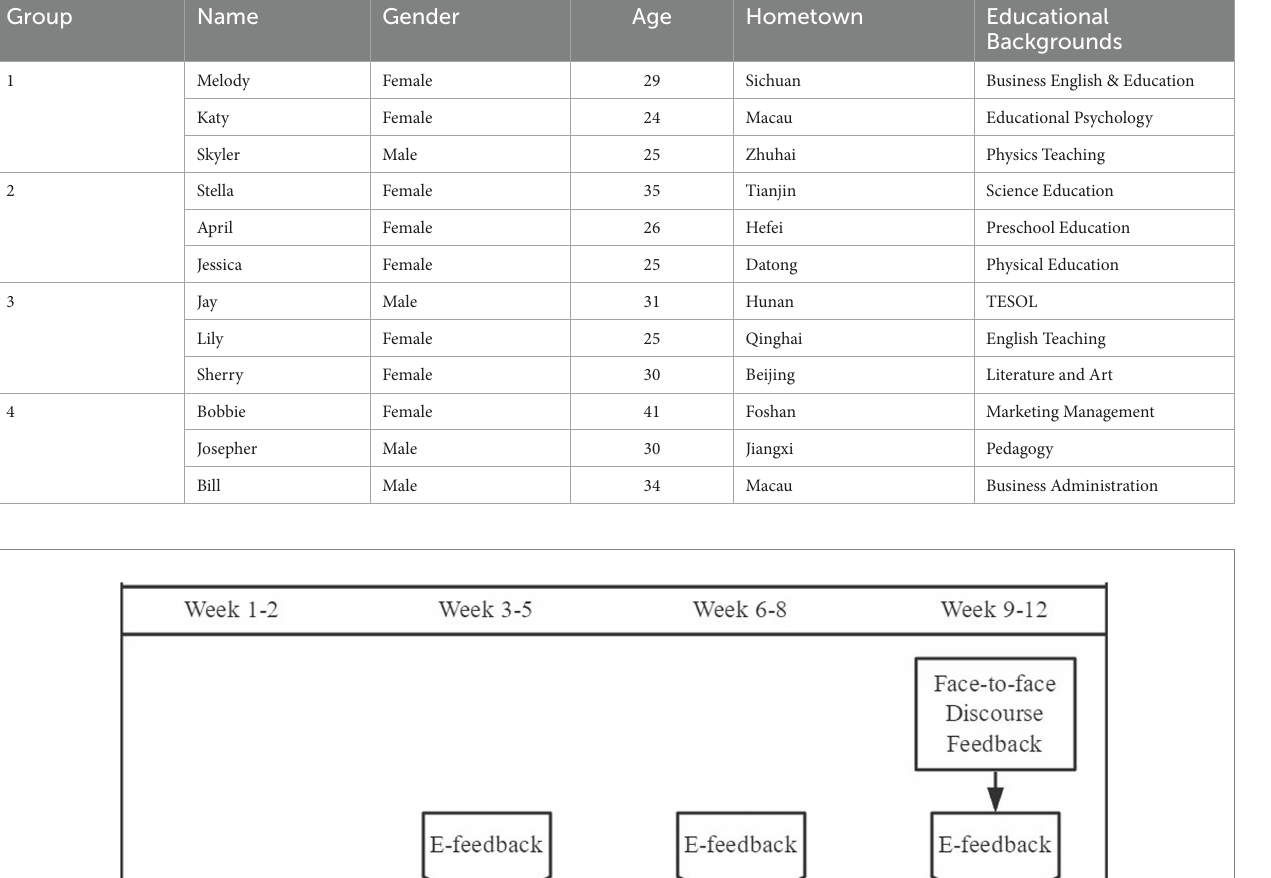
TABLE 1 Participants’ information.